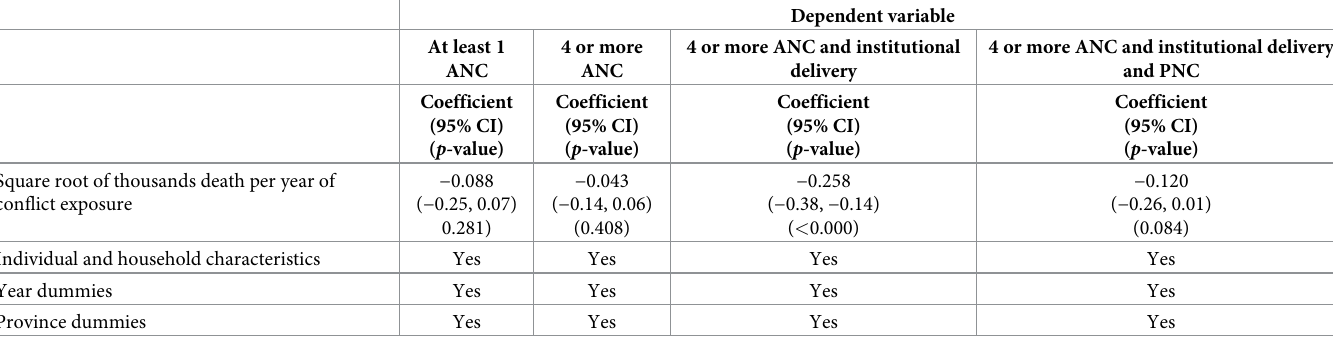
Table 6. Associations between intensity of exposure to conflict and CoC using continuous measure of confict